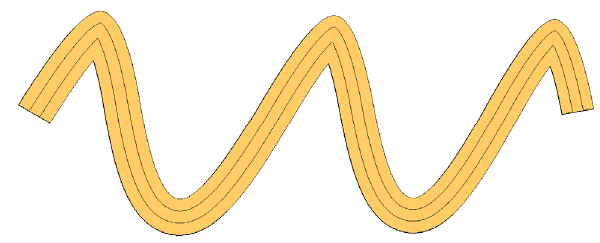
Figure 9. Periodic treatment for continuous fold belts.